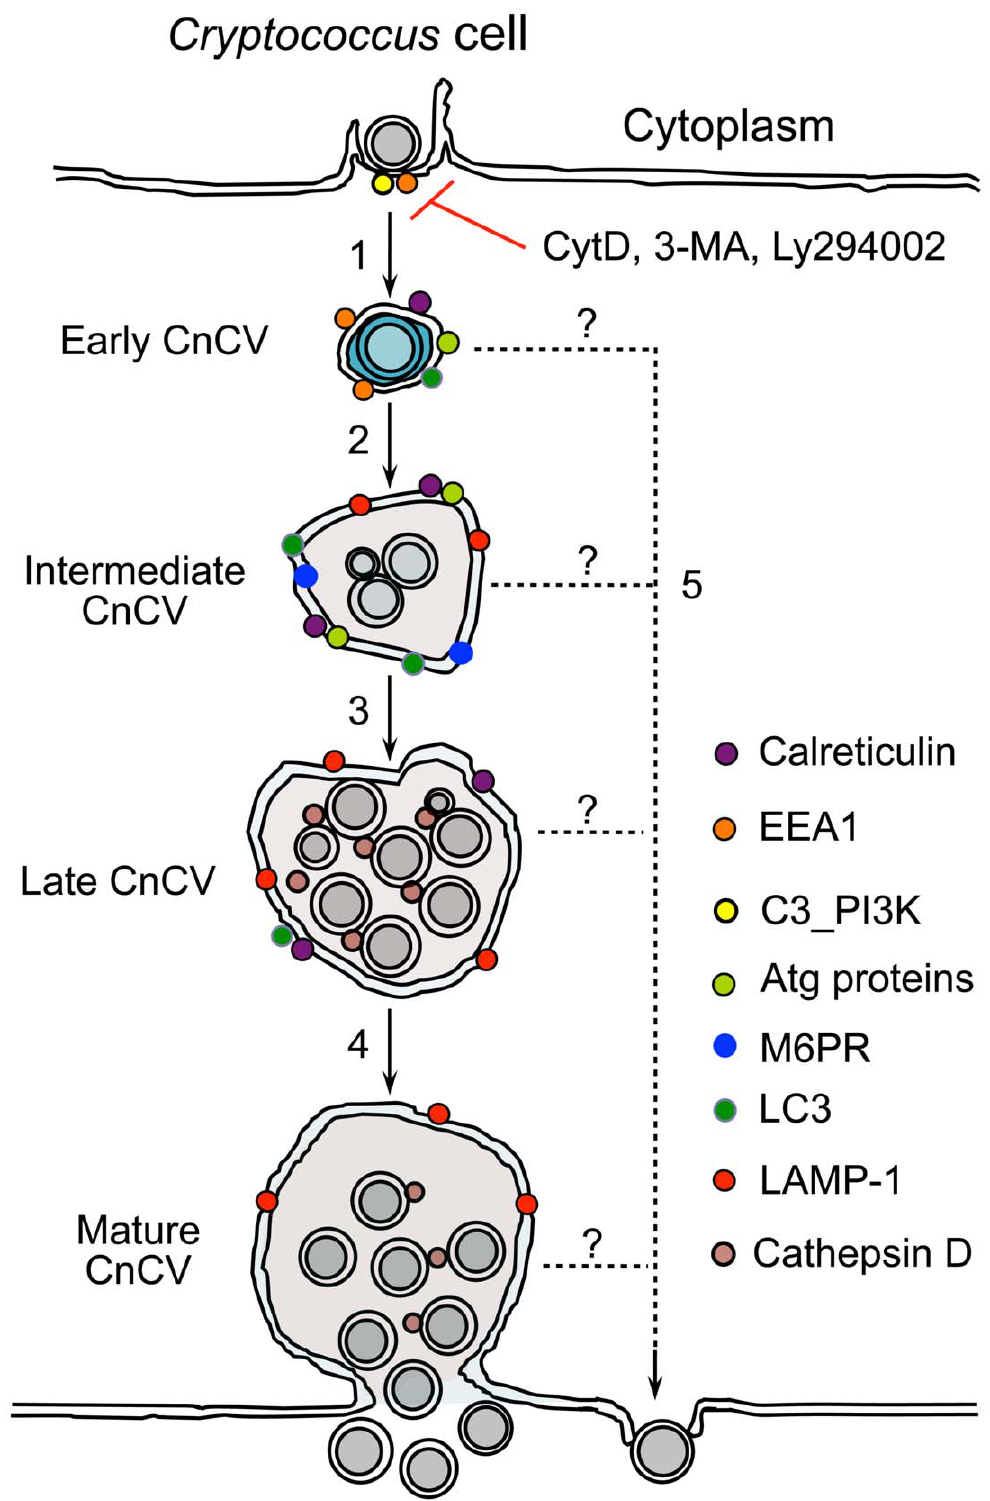
Figure 9. Proposed model depicting Cn subversion of Atg proteins for intracellular replication and dissemination. Host cell phagocytosis of Cn cells is class III PI3-kinase (C3_PI3K) and actin-dependent. This process is blocked by the PI3-kinase inhibitors 3-MA, LY294002 and the actin polymerization inhibitor cytochalasin D (CytD) (1). Internalized Cn resides in a Cn containing vacuole (CnCv). Early CnCvs interact with components of the endocytic pathway and sequentially obtain early endosome (EEA1), late endosome (M6PR) and lysosome (LAMP-1 and cathepsin D) markers (2). Infection by Cn may also activate the host cell autophagy pathway. Atg proteins such as Atg5, Atg9a and LC3 are recruited to the vicinity of CnCVs. Activated host cell Atg proteins promote the maturation of early CnCVs to form intermediate CnCVs (2). These compartments support Cn replication (3). Finally, late CnCVs may fuse with the plasma membrane, via an undefined mechanism, which results in the escape of